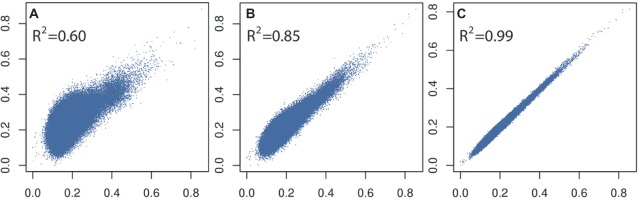
Comparison and correlations of SNP-based kinship estimates (rG) (A) 96 versus 7,500 SNPs, (B) 384 versus 7,500 SNPs, and (C) 3,000 versus 7,500 SNPs calculated on 1,000 L. vannamei samples.